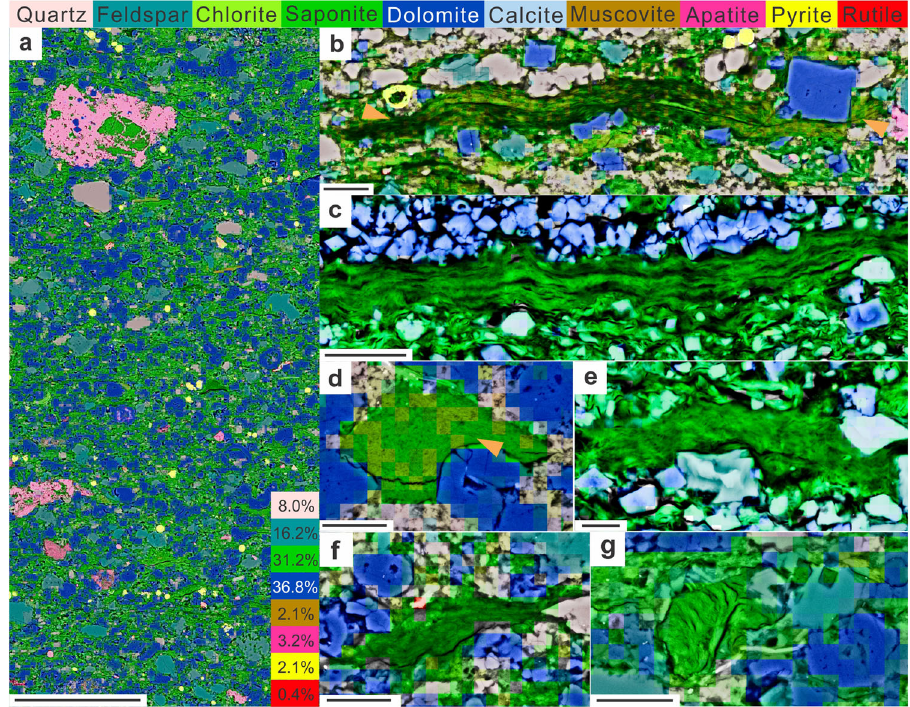
Fig. 4 SEM-EDS mineral mapping images of representative examples of saponite from the Doushantuo Formation and Green River Formation. Scale bars represent 100 μ m in ( a ) and 10 μ m for ( b – g ). a SX22, a 250*550 μ m region providing overview of a saponite-rich and less altered sample. b Qlk7, wavy laminae of authigenic saponite particles (partially chloritized) displaying approximately bedding-parallel orientation of the fi ne clay crystals. Individual laminae are largely free of detrital grains and are curved due to burial compaction (yellow arrows). Saponite deformed around dolomite and other brittle grains by compaction ( c ) Laminae of bedding-parallel saponite in the Green River Formation, USA. d SX4, pore- fi lling saponite aggregate grain (partially chloritized) with randomly oriented individual clay particles. Some deformation from burial compaction (yellow arrow), but largely uncompacted due to silt bridging effect. e Randomly oriented saponite in the Green River Formation fi lls an intergranular pore. f SX17, intergranular pore- fi lling saponite with individual saponite particles partially oriented. g SX22, saponite intragranular pore- fi ll in feldspar. COMMUNICATIONS EARTH & ENVIRONMENT| (2022) 3:165